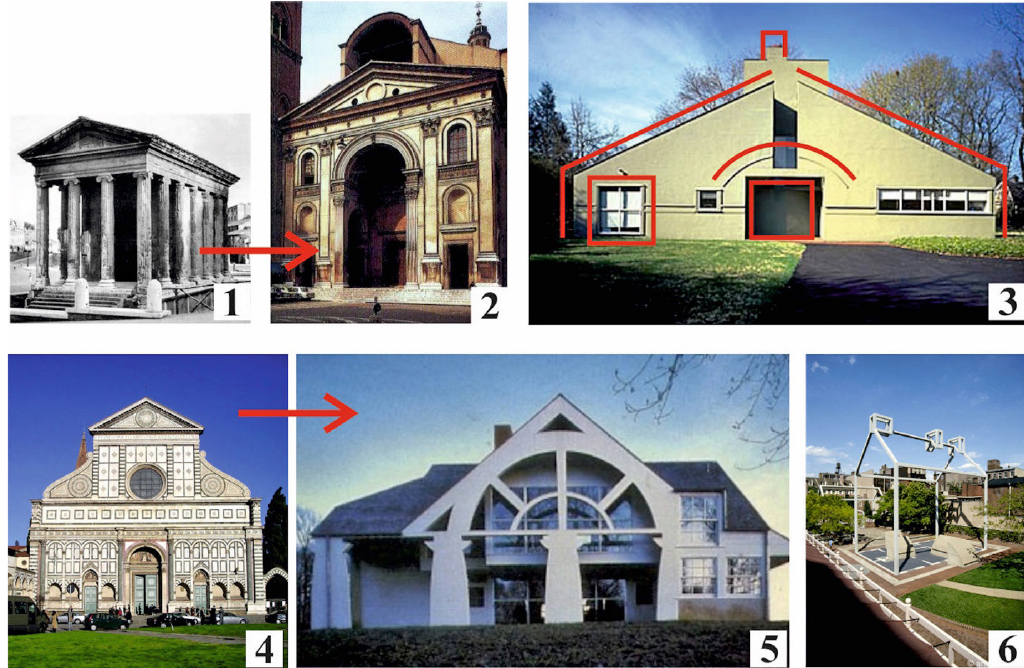
Figure 7. The method of historical association. Comparison of Ancient, Renaissance and Postmodern buildings: 1. Temple of Fortune Virilis in Rome, 1st century BC; 2. Ch. Sant Andrea, Mantova, 1470; 3. Vanna